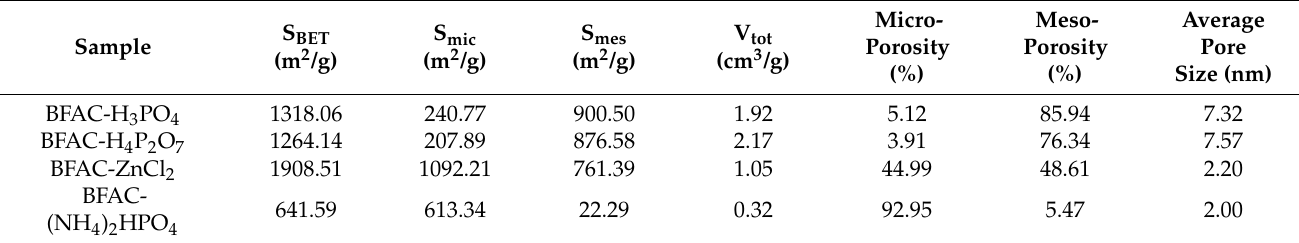
Figure 3. Pore size distribution curves of BFACs activated by different activators: ( a ) mesoporous; ( b ) micropores. Table 1. Specific surface area BET and pore structure parameters of BFACs.